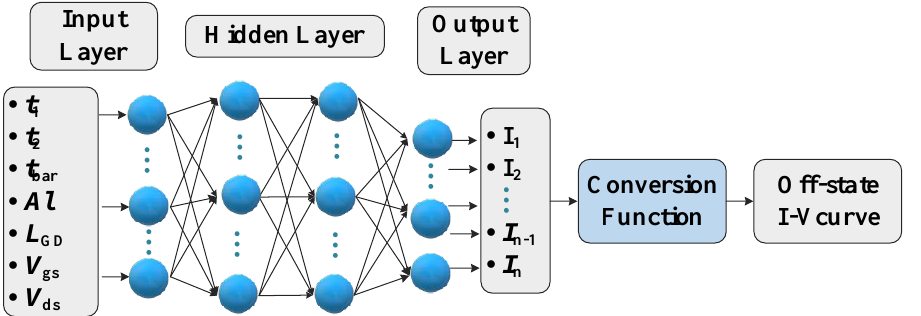
Figure 3. The overall flow of the proposed framework for off-state performance characterization.